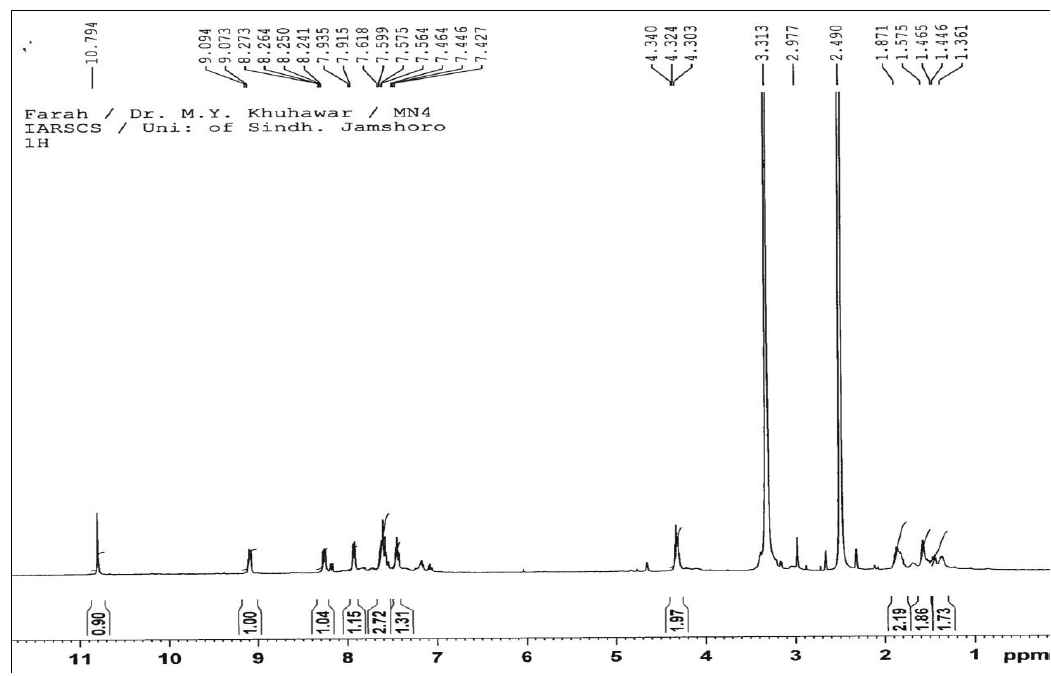
Figure S9: 1 HNMR spectrum of dialdehyde monomer o -HON